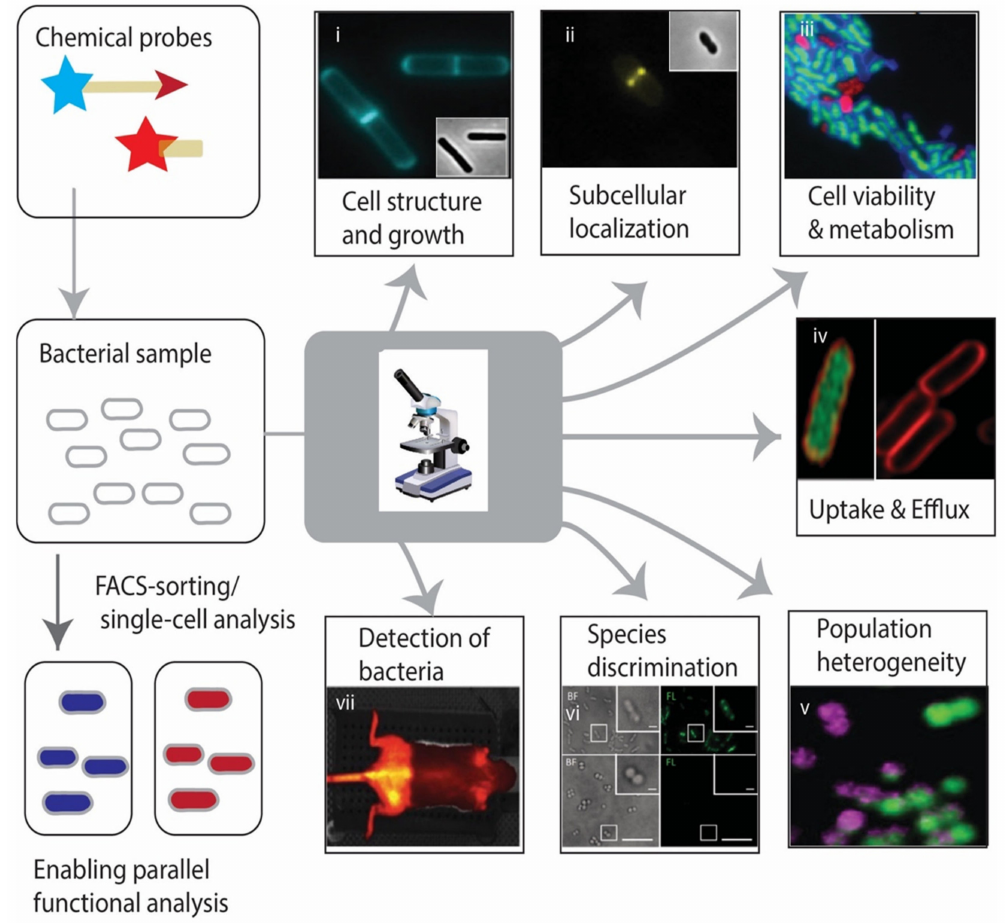
Figure 2. Applications of chemical probes in bacterial imaging. The images demonstrates the utility in di ffi cult probes for visualizing and potential for purification, isolation and downstream analysis by cell-sorting. Exemplary imaging applications are illustrated with images from primary publications: ( i ) Uniform labeling of PG in live B. subtilis cells using FDAAs (HADA) [112]. The figure is reproduced with permission from [112]. ( ii ) The subcellular localization of PBPs during cell division and elongation in Lactococcus lactis is depicted by Bocillin-FL labeling [130]. The figure is reproduced from [130] under a Creative Commons Attribution (CC BY) license. ( iii ) Live–dead labeling in E. coli demonstrates FDAAs (HADA) labeling in live cells (blue) but not dead cells (red) [112]. The figure is reproduced with permission from [112]. ( iv ) Internalization of ciprofloxacin fluorophore derivatives in live E. coli with (green, left) and without (red, right) e ffl ux pump inhibitor [126]. The figure is reproduced under a Creative Commons Attribution 3.0 Unported License from [126]—Published by The Royal Society of Chemistry. ( v ) Absence of acticity-based probes (ABP) labeling (purple) in some GFP expressing S. aureus cells (green) during exponential phase indicates phenotypically distinct subpopulations [7]. The figure is reproduced with permission from [7]. ( vi ) Vibrios are selectively labeled by the vibroferrin-derived fluorescent siderophore conjugate vibrioferrin-fluorescein (VF-FL) (top) while other species are not labeled (bottom) [60]. The figure is adapted with permission from [60]. Copyright (2017) American Chemical Society. ( vii ) Non-invasive optical in vivo imaging of a mouse with E. coli and S. aureus -induced myositis in the limb using fluorescently labeled vancomycin